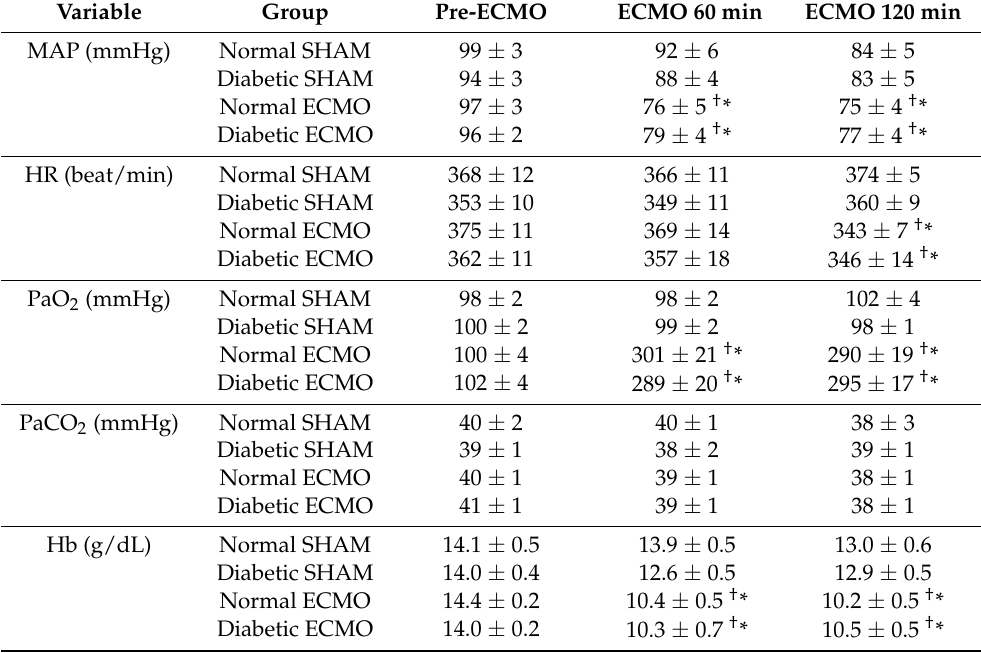
Table 1. Hemodynamic variables, blood gas partial pressures, hemoglobin, and pH before and during